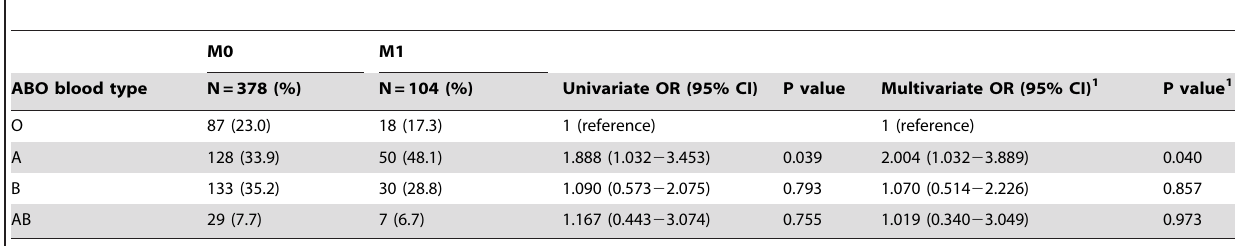
Table 5. The association between ABO blood types and metastasis in patients with cutaneous malignant melanoma: Univariate and multivariate logistic regression